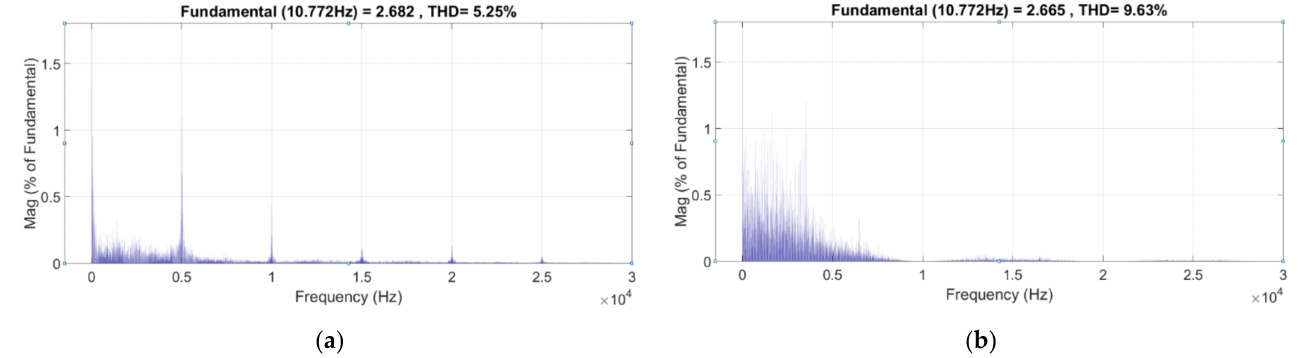
Figure 5. Comparing the spectral content of stator currents: ( a ) M 2 PC; ( b ) FCS-MPC.